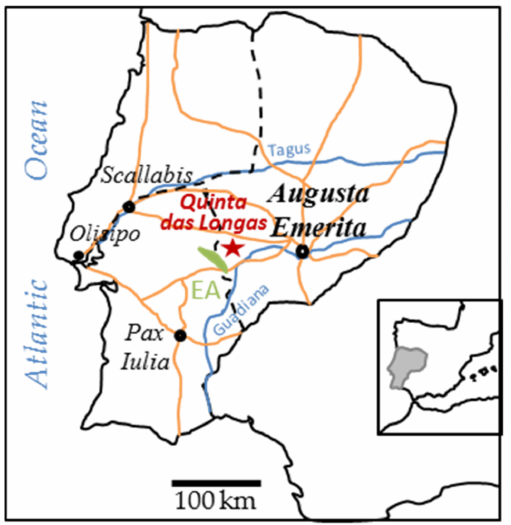
Figure 1. Quinta das Longas location (38.9479158, − 7.6507533) in the Lusitanian territory of Hispania. EA is the Estremoz Anticline marble